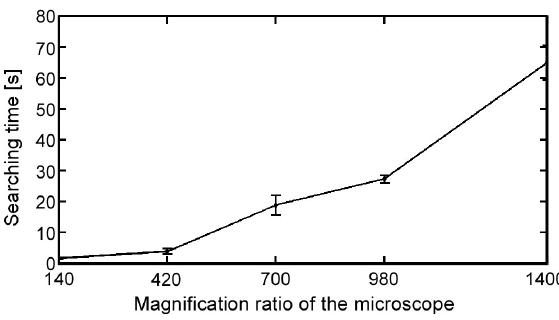
Figure 6. Magnification ratio control efficiency in reducing the searching time required to find a target. The field of view (FOV) dimensions of the online vision ranged from 1408 µm × 1408 µm to 202 µm × 202 µm.